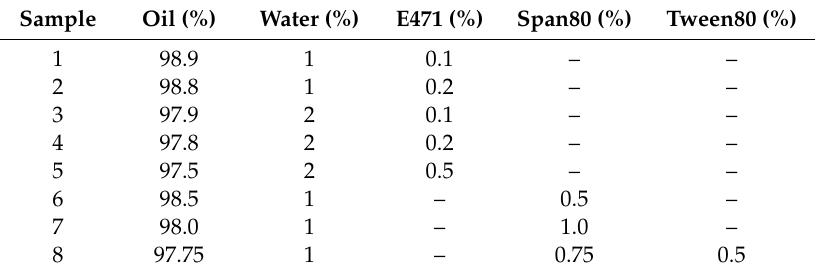
Table 1. Composition of water-in-oil emulsions (w / o) emulsion